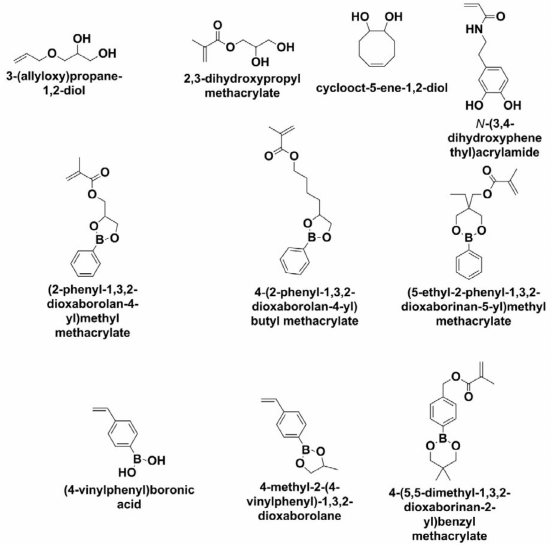
Figure 6. Chemical structures of vinyl monomers containing diol, boronic acid, or boronic acid cyclic ester moiety in their